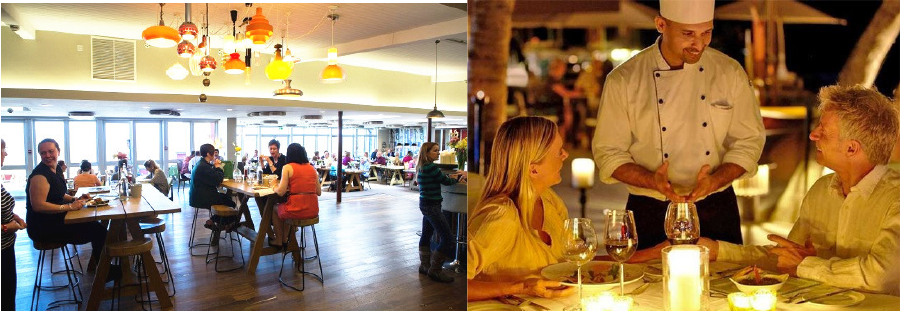
Figure 1. Example images used for the visual elicitation of contexts in the screening test. Left: a casual restaurant; right: a luxurious restaurant.